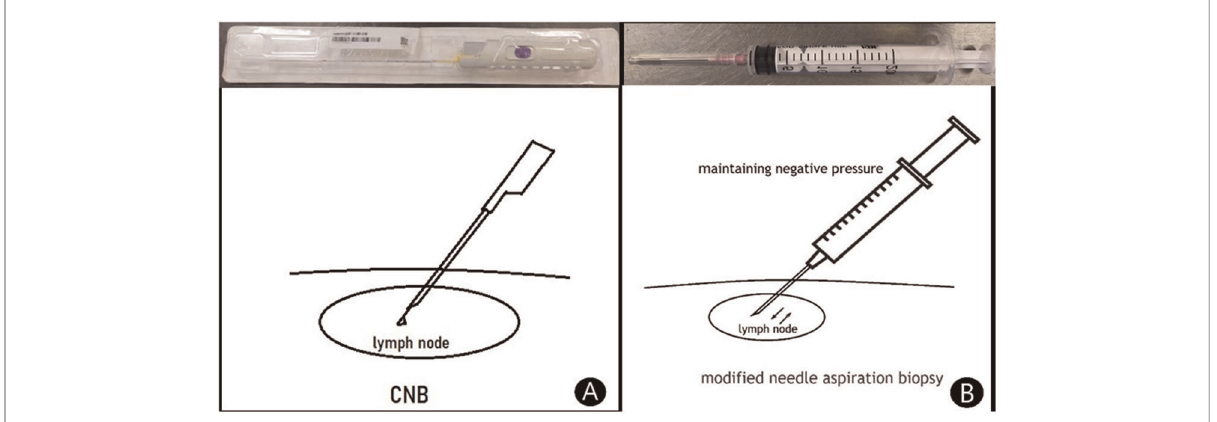
FIGURE 1 The visuals of both methods. ( A ) Core needle biopsy (CNB). Use Bard automatic biopsy gun with 18G biopsy needle to directly puncture enlarged lymph nodes for biopsy. ( B ) Modi fi ed needle aspiration biopsy. Use a 20 ml syringe with an 18G needle to puncture into the enlarged lymph node, and then maintain 20 ml negative pressure for repeated aspiration 15 – 20 times for needle